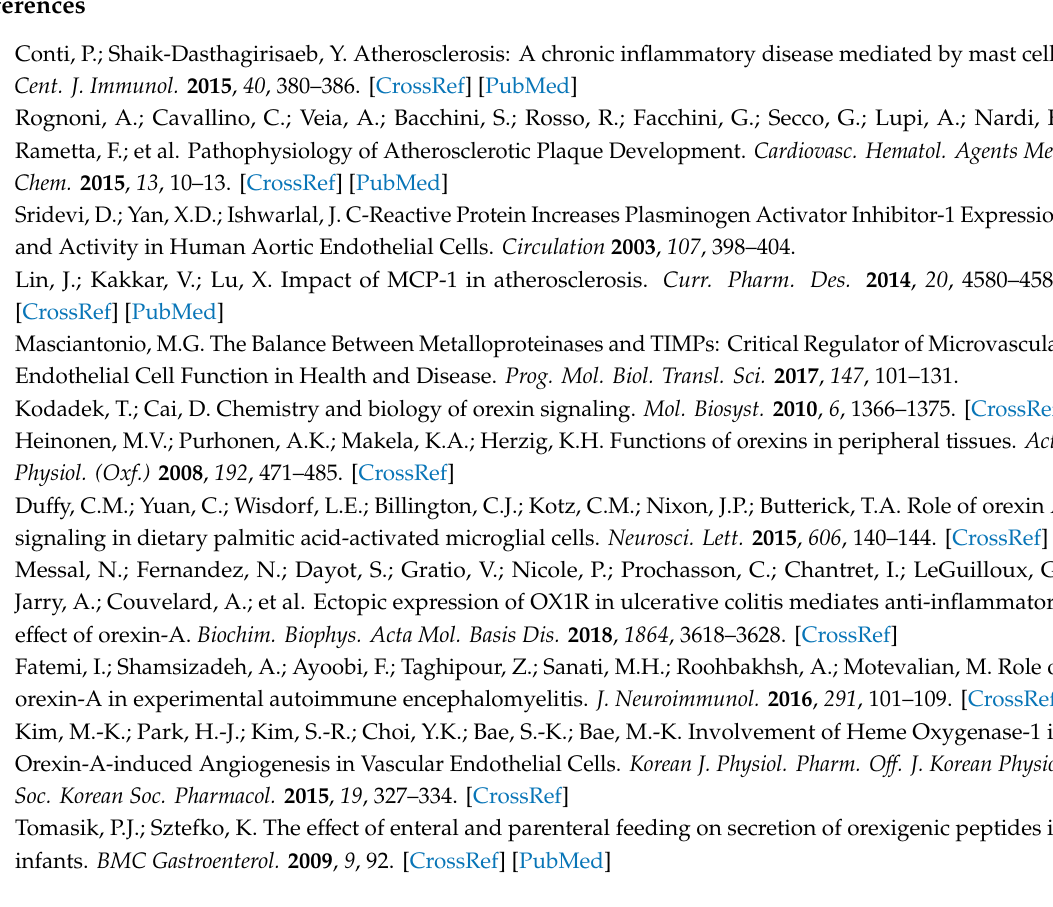
Figure S1: MMP-2 protein levels and OX1R mRNA expression in HAECs. ( A ). MMP-2 protein levels (measured by western blotting) is reduced by extension of starvation time in HAECs. ( B ). OX1R mRNA is detected in HAECs by